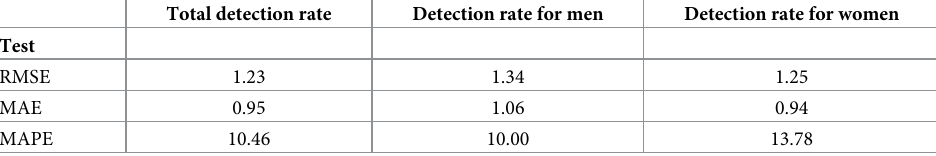
Table 3. Predictive analysis of the detection rates models, Imperatriz, MA, Brazil